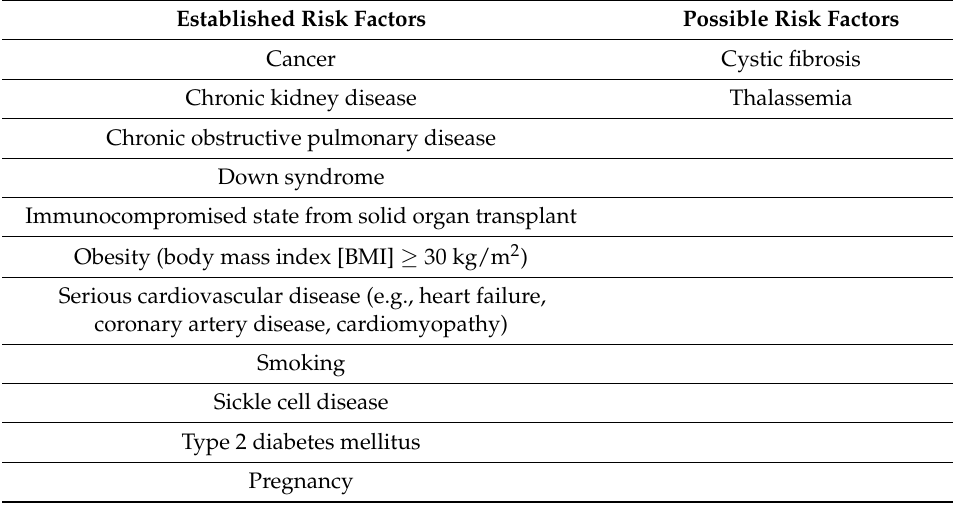
Table 1. Risk factors for severe